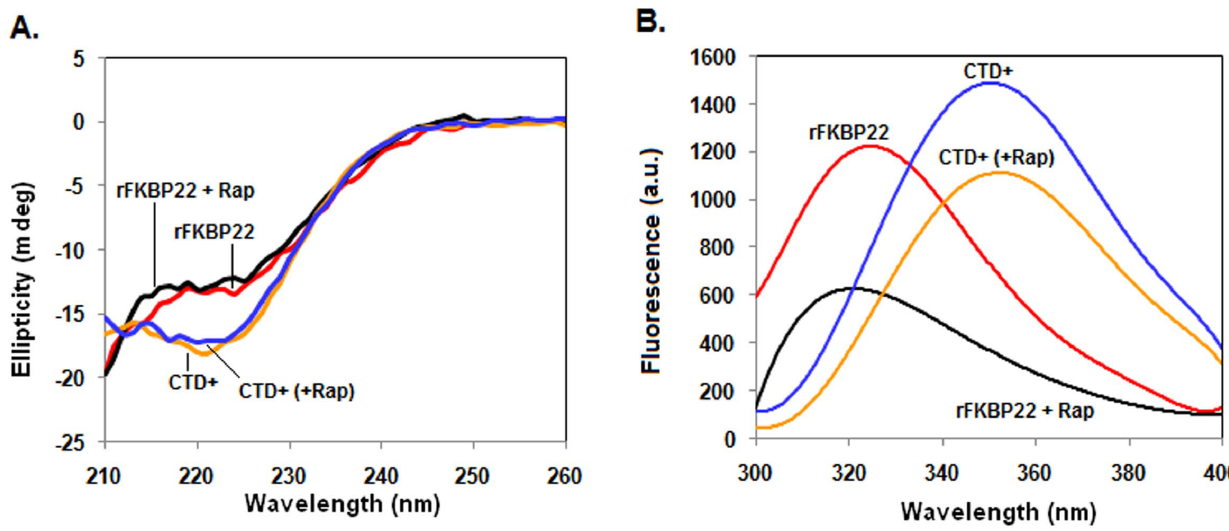
Figure 1. Far-UV CD (A) and intrinsic Trp fluorescence (B) spectra of the designated proteins (bound with or without rapamycin) were recorded at room temperature.